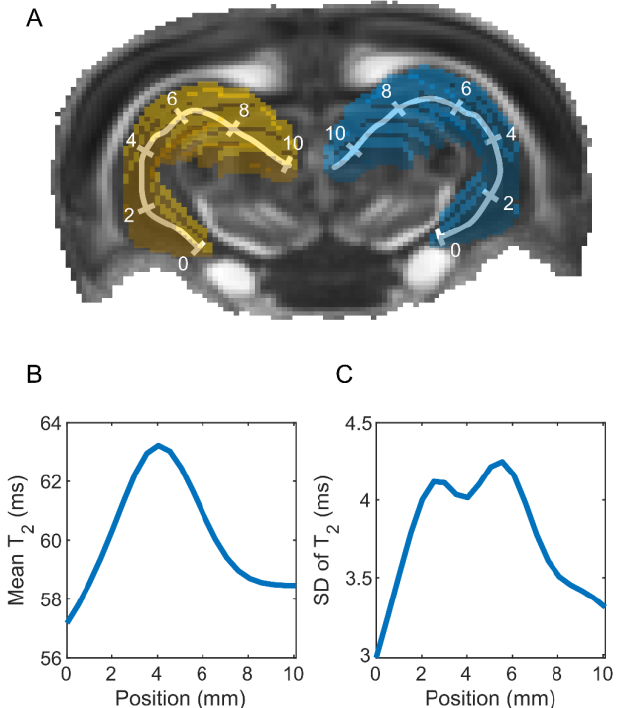
Figure 4. Computation of MRI metrics along the septotemporal axis of the rat hippocampus. ( A ) Ipsilateral (left, yellow) and contralateral (right, blue) hippocampus in the template brain of a sham-operated control. The left and right hippocampal skeletons are shown as polylines with 2-mm segments, in which the temporal end of the hippocampus is labeled as 0. The value of each imaging voxel within the hippocampus was projected onto the skeleton after applying a Gaussian spatial filter. ( B ) Weighted mean and ( C ) standard deviation (SD) of the T 2 relaxation time along the hippocampal axis on day 2 after TBI for one animal. The measures were computed for each animal and MRI parameter map.